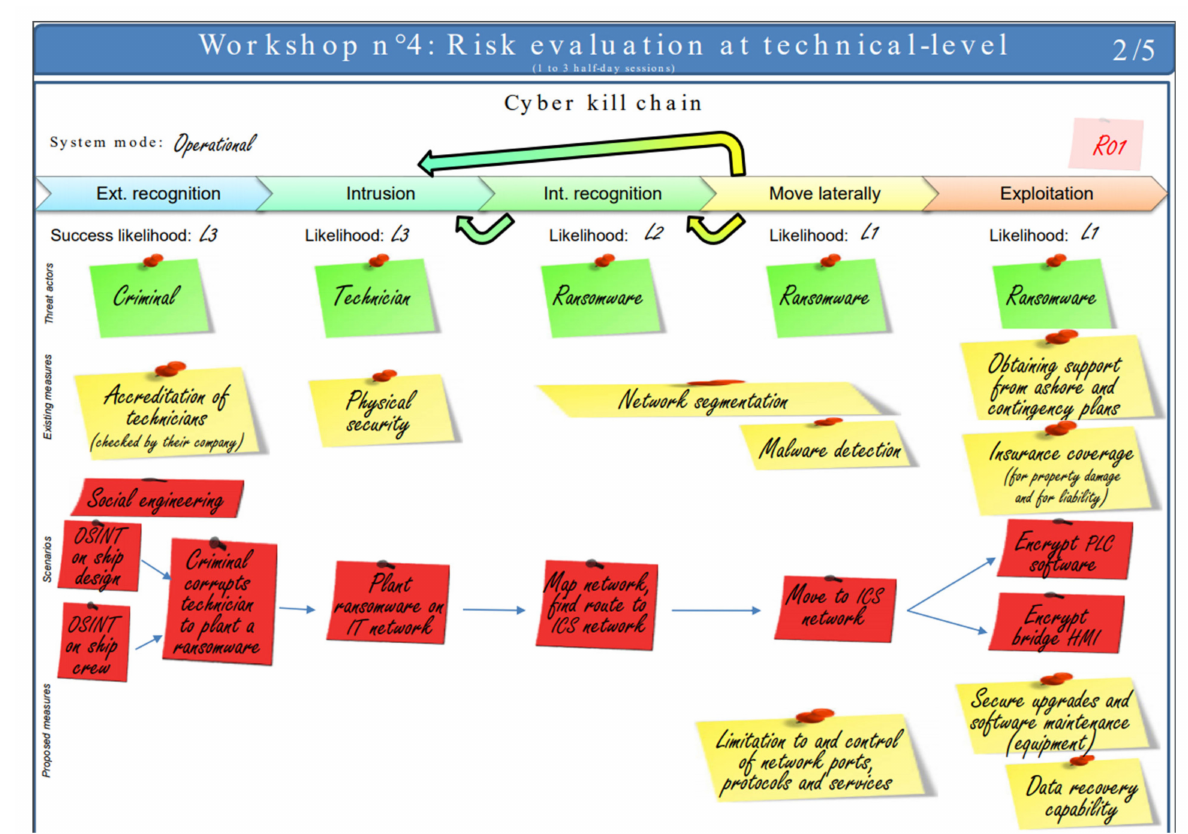
Figure 13. Naval use case—risk evaluation at technical-level